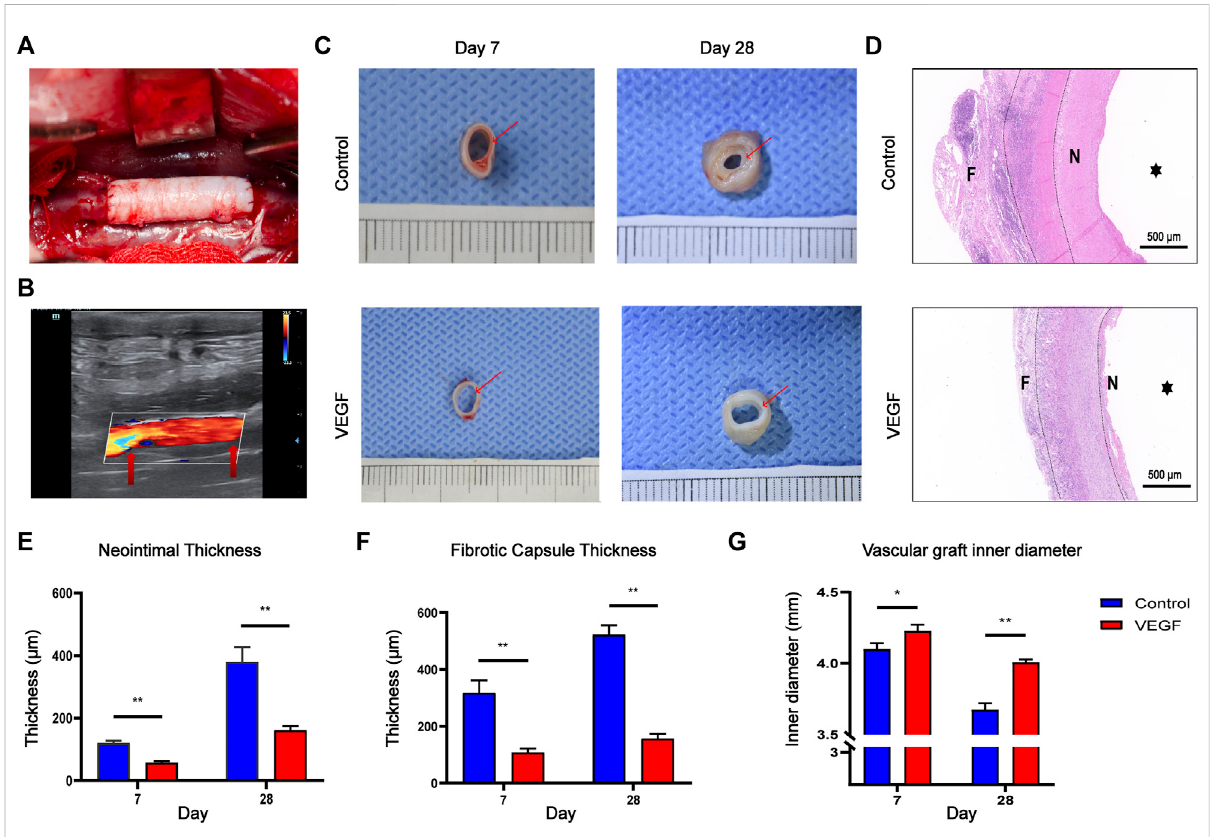
FIGURE 8 Macroscopic images of the rabbit abdominal artery implantation model (A) . Color Doppler ultrasound images of vascular grafts post- implantation.Redarrowsdepicttheanastomosis (B) .Grossimagesofvasculargraftsatdays7and28ineachgroup.Redarrowsdepicttheneointima of vascular grafts (C) . HE staining of vascular grafts at day 28 in each group. F, fi brous capsule. N, neointima. , vascular lumen. Between the two dashed lines depicts the decellularized BIMA (D) . Measurement of neointimal thickness of vascular grafts in each group (E) . Measurement of vascular grafts fi brous capsule thickness (F) . Measurement of inner diameter of vascular grafts in each group (G) . * p < 0.05. ** p < 0.01. ns represents no signi fi cant